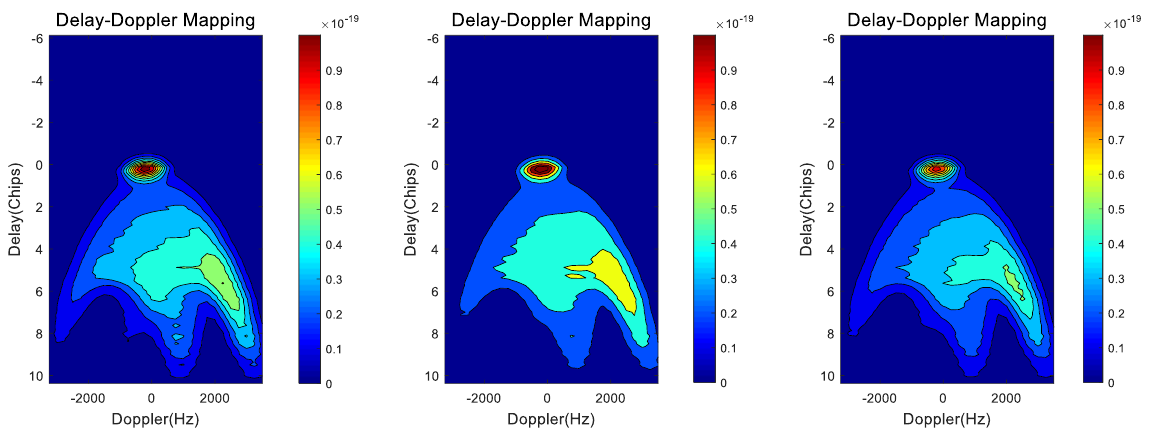
Figure 6. Vegetation DDMs at LR polarization ( left ), VR polarization ( middle ), and HR polarization ( right ).